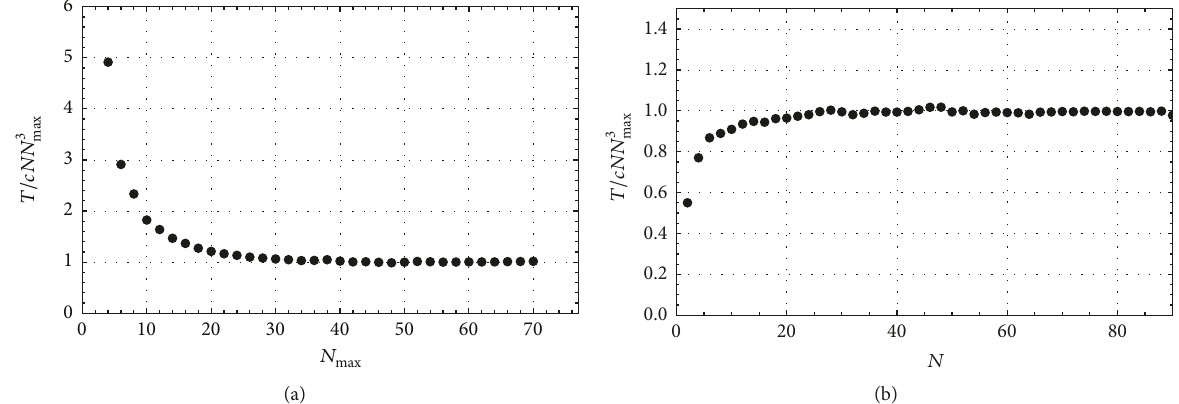
Figure 5: CPU time versus 𝑁 max (a) and 𝑁 (b) for the NLSE, (29). Parameters used: for (a), 𝑁 = 400 . For (b), 𝑁 max = 70 . For both plots, 𝑁